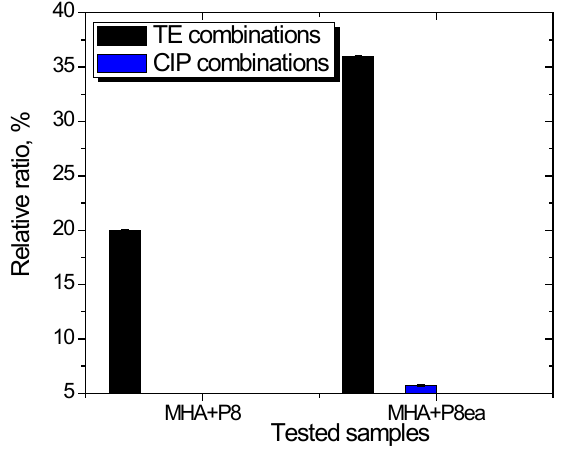
Figure 12: E. coli ATCC 35218 response.